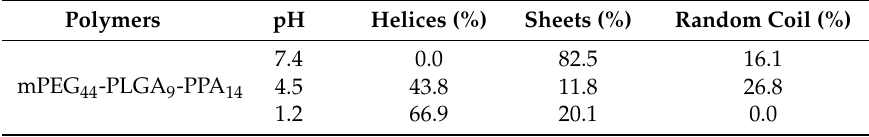
Figure 6. Circular dichroism spectra of mPEG-PLGA-PPA micelles at different pH. Table 3. Secondary conformation of polymer micelles at different pH.